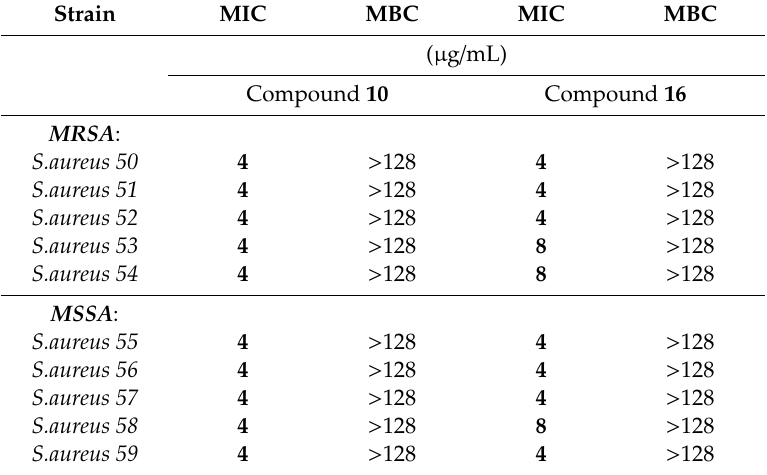
Table 4. Minimal inhibitory concentration (MIC) and minimal bactericidal concentration (MBC) of 10 and 16 against clinical MRSA and MSSA strains. Strain MIC MBC MIC MBC ( µ g / mL) Compound